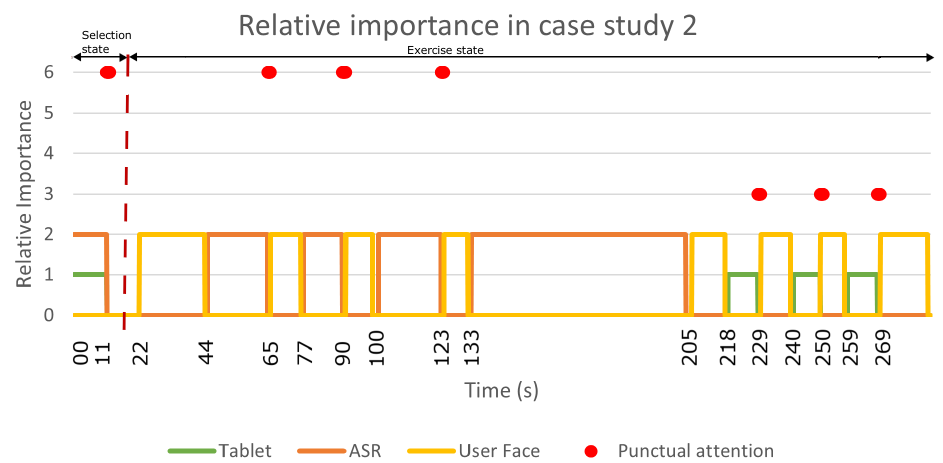
Figure 9. The relative importance of the detectors during sustained and punctual attention in case study 2. The orange, yellow and green lines show the sustained attention of the ASR, the user’s face and the tablet, respectively. The red dots display the punctual attention that was detected during the case study. The user’s answers produced the first three dots using ASR, while the tablet responses produced the last four